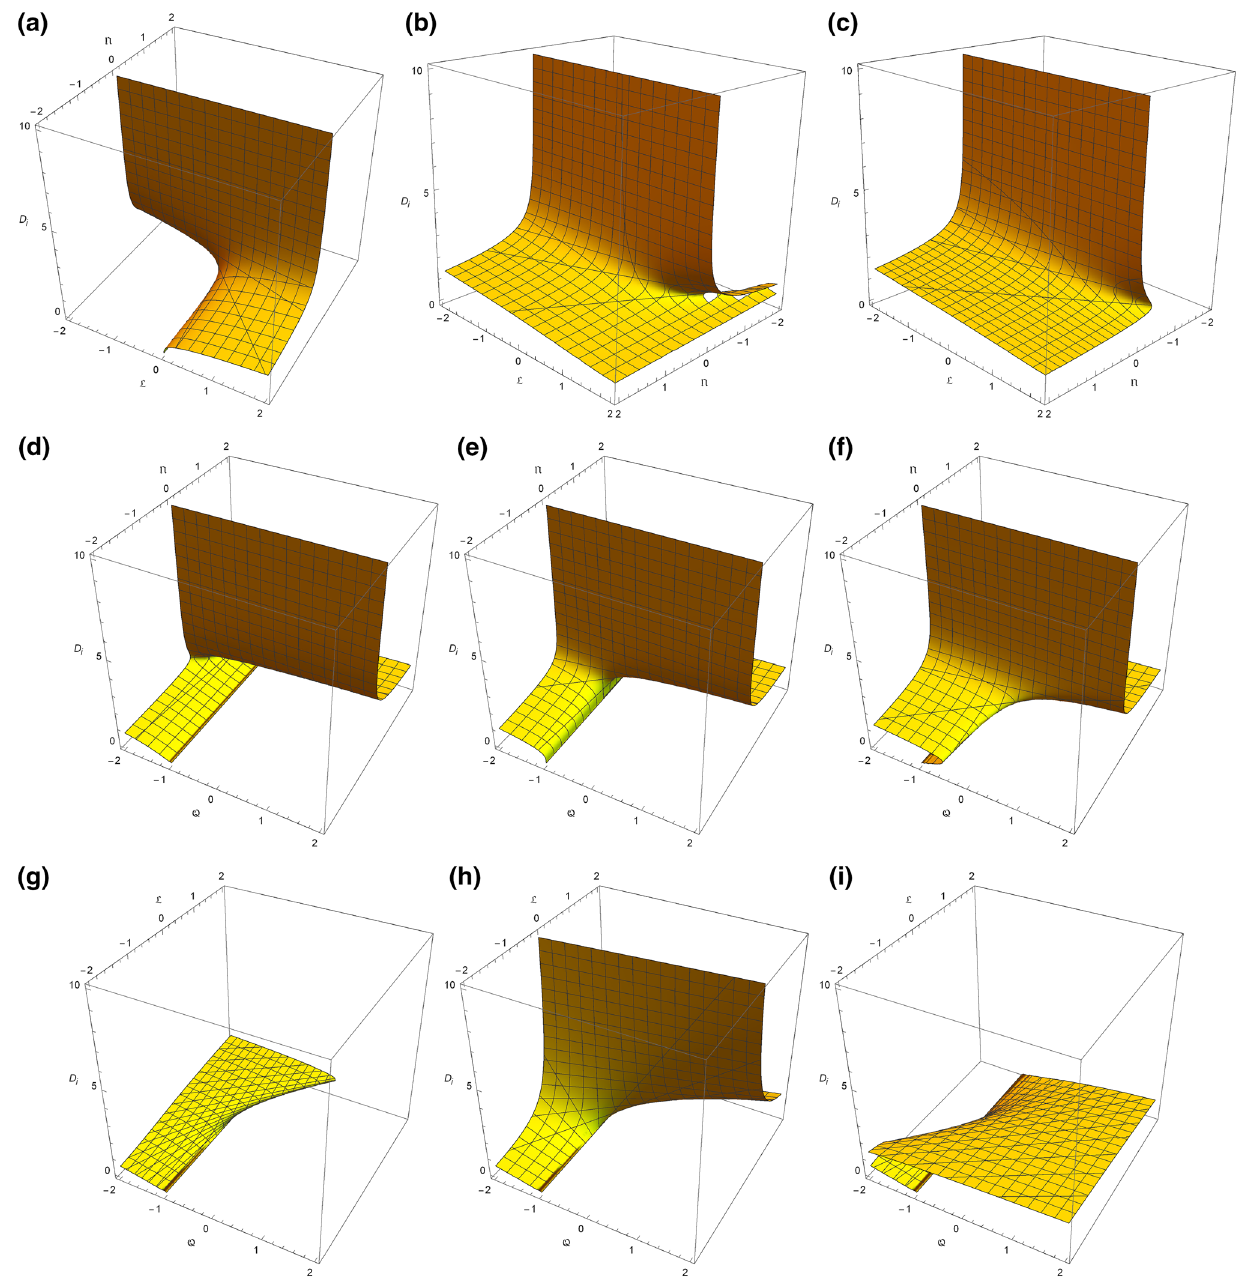
Fig. 17 The variation of D i versus typical values of the L , Q and N parameters in (48) for the cosmological constant-like background. We have set M = 1 without loss of generality in all the plots. The plots a – c